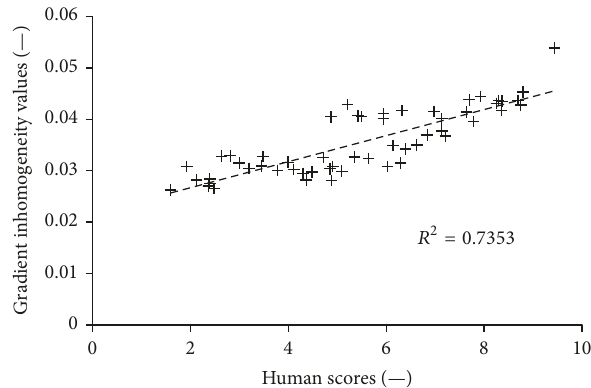
Figure 2: The correlation of the human scores and the edge value- based method.